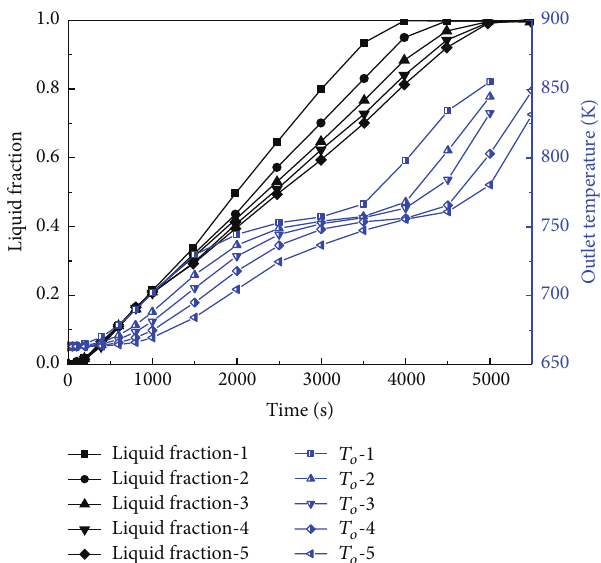
Figure 18: The liquid fraction and outlet temperature under differ- ent Ste or Re numbers conditions for fixed input power. Table 3: The working conditions at the same inlet power.